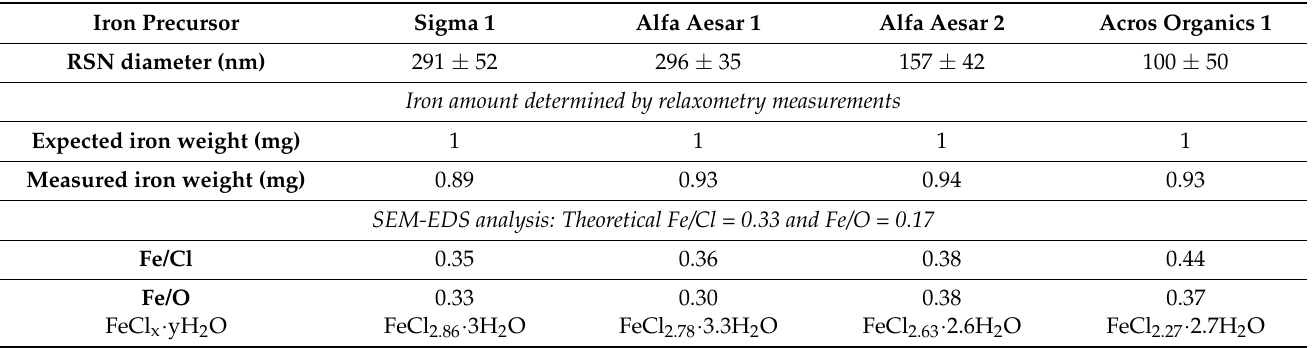
Table 3. Fe/Cl and Fe/O atomic ratios determined by SEM-EDS and amount of iron in the different iron precursors determined by relaxometry